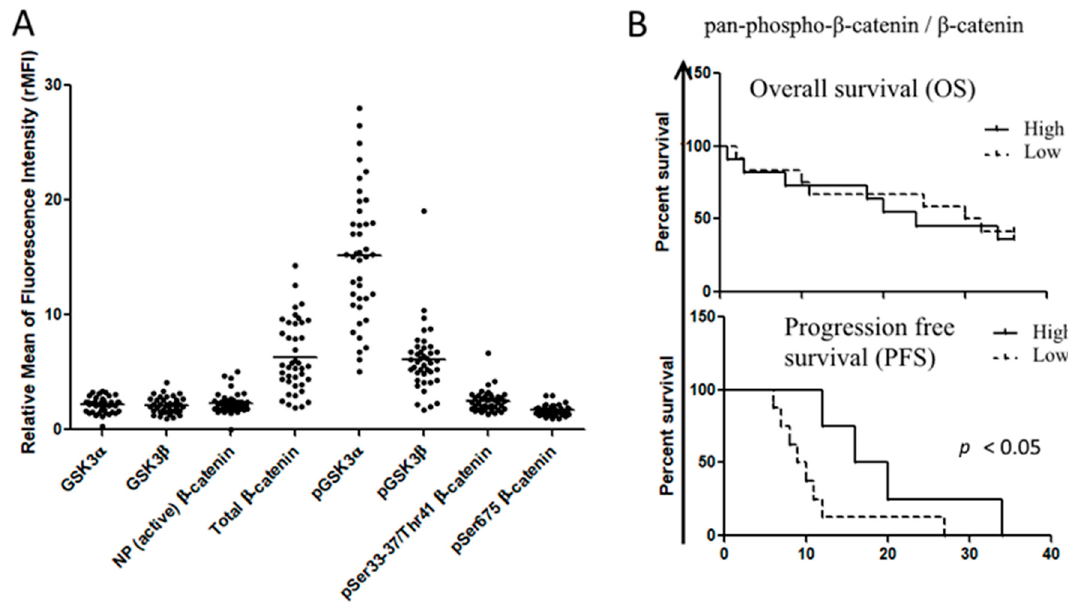
Figure 3. Expression of Wnt signaling in primary AML samples. ( A ) Flow cytometric analysis of Wnt components in AML primary samples ( n = 60), probed with specific primary antibody and labeled with FITC-conjugated secondary antibodies. Data were expressed as relative median of fluorescence intensity. ( B ) The ratio between inactive Ser33–37/Thr41-phospho- β -catenin and total β -catenin was evaluated for each sample and classified as high ratio or low ratio when they were above and below the mean ratio value for all samples, respectively. Gehan–Breslow–Wilcoxon analysis was used to establish the difference in overall survival and progression-free survival among the groups.